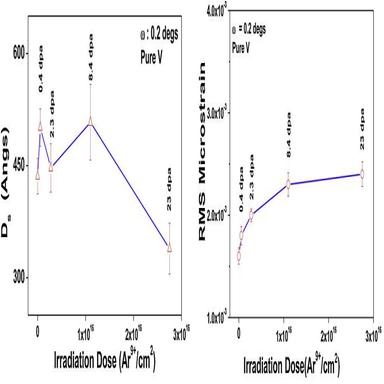
(a) & (b): Variation of coherent Domain size Ds and RMS Microstrain as a function of irradiation dose at peak damage region at Pure V sample (as analyzed by Modified Rietveld Method).